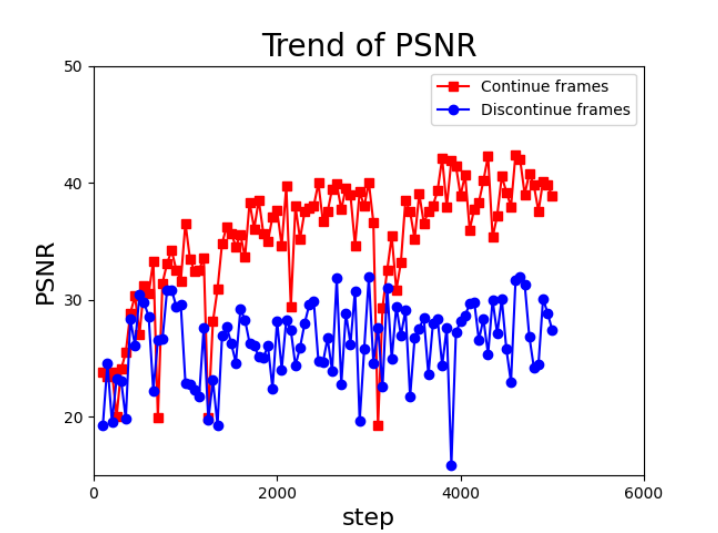
Figure 7. Graph of PSNR variation with higher peak PSNR and higher boost rate for consecutive frames.